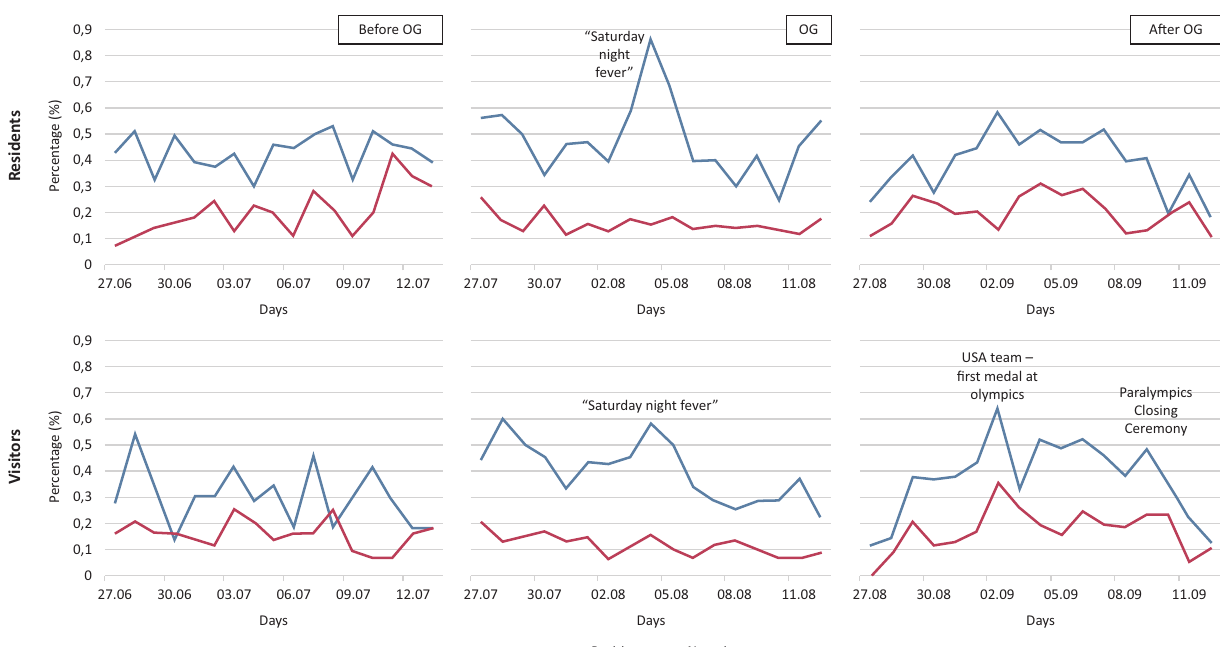
Figure 7. Daily sentiment analysis distribution for residents and visitors for the “olympic” topic (percentage of total number of tweets in the given temporal bin for the respective categories).